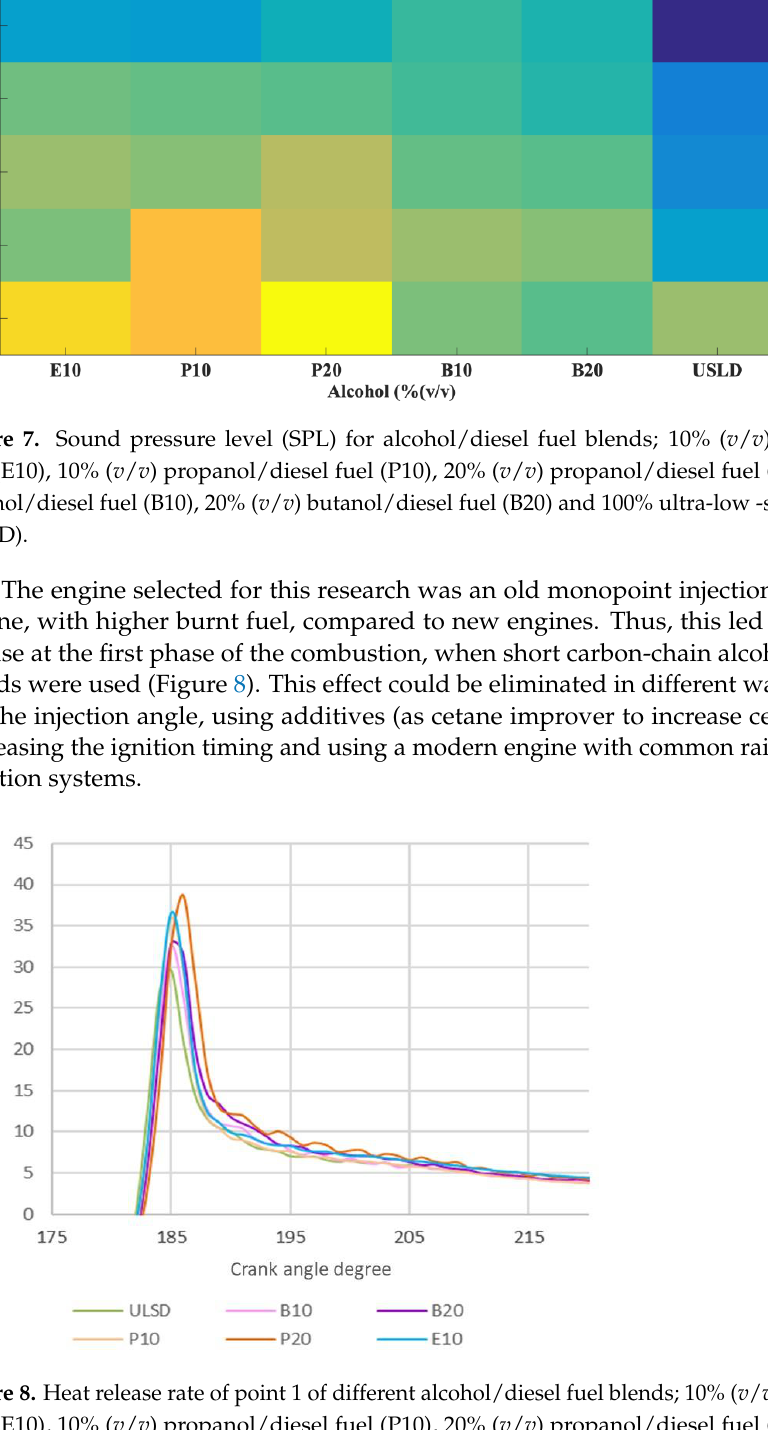
Figure 8. Heat release rate of point 1 of different alcohol/diesel fuel blends; 10% ( v / v ) ethanol/diesel fuel (E10), 10% ( v / v ) propanol/diesel fuel (P10), 20% ( v / v ) propanol/diesel fuel (P20), 10% ( v / v ) butanol/diesel fuel (B10), 20% ( v / v ) butanol/diesel fuel (B20) and 100% ultra-low -sulfur diesel fuel (USLD).